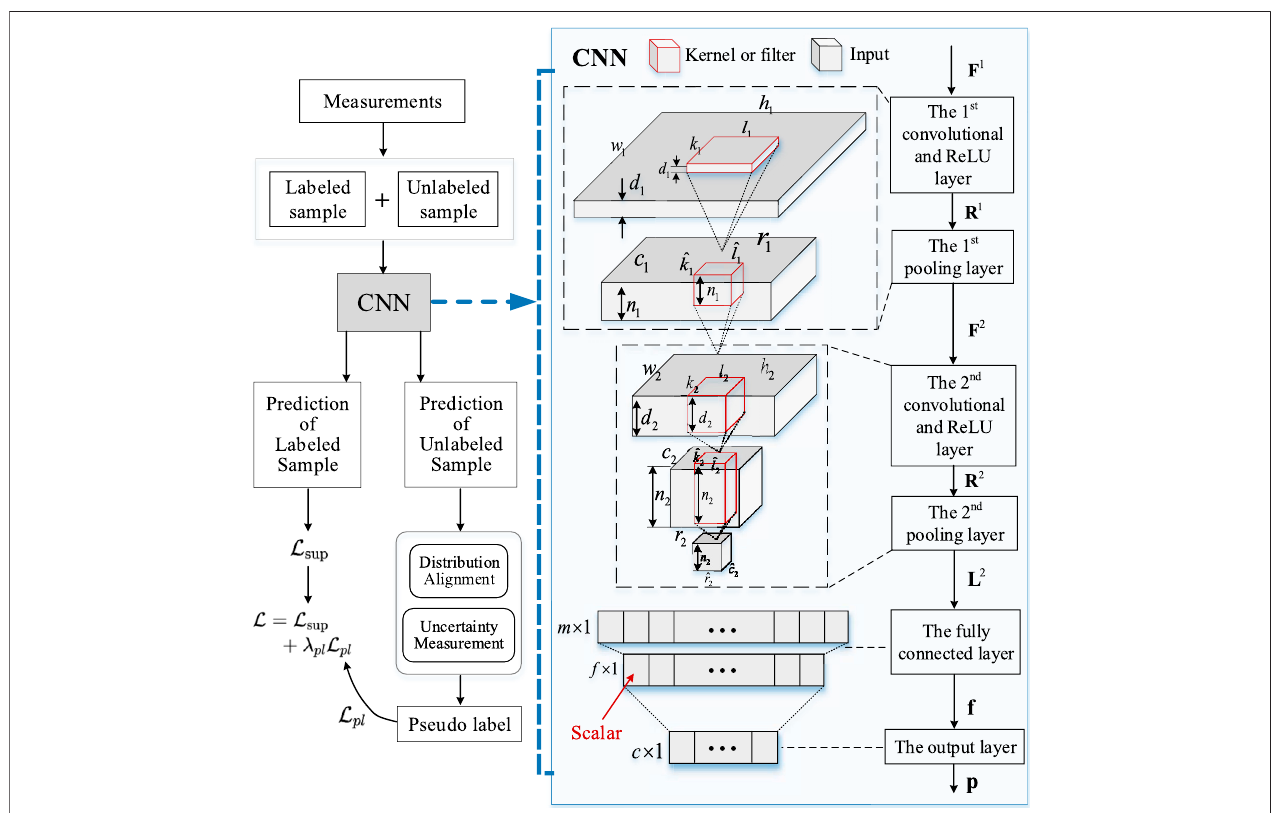
FIGURE 6 | An overview of the PL-based approach for event classi fi